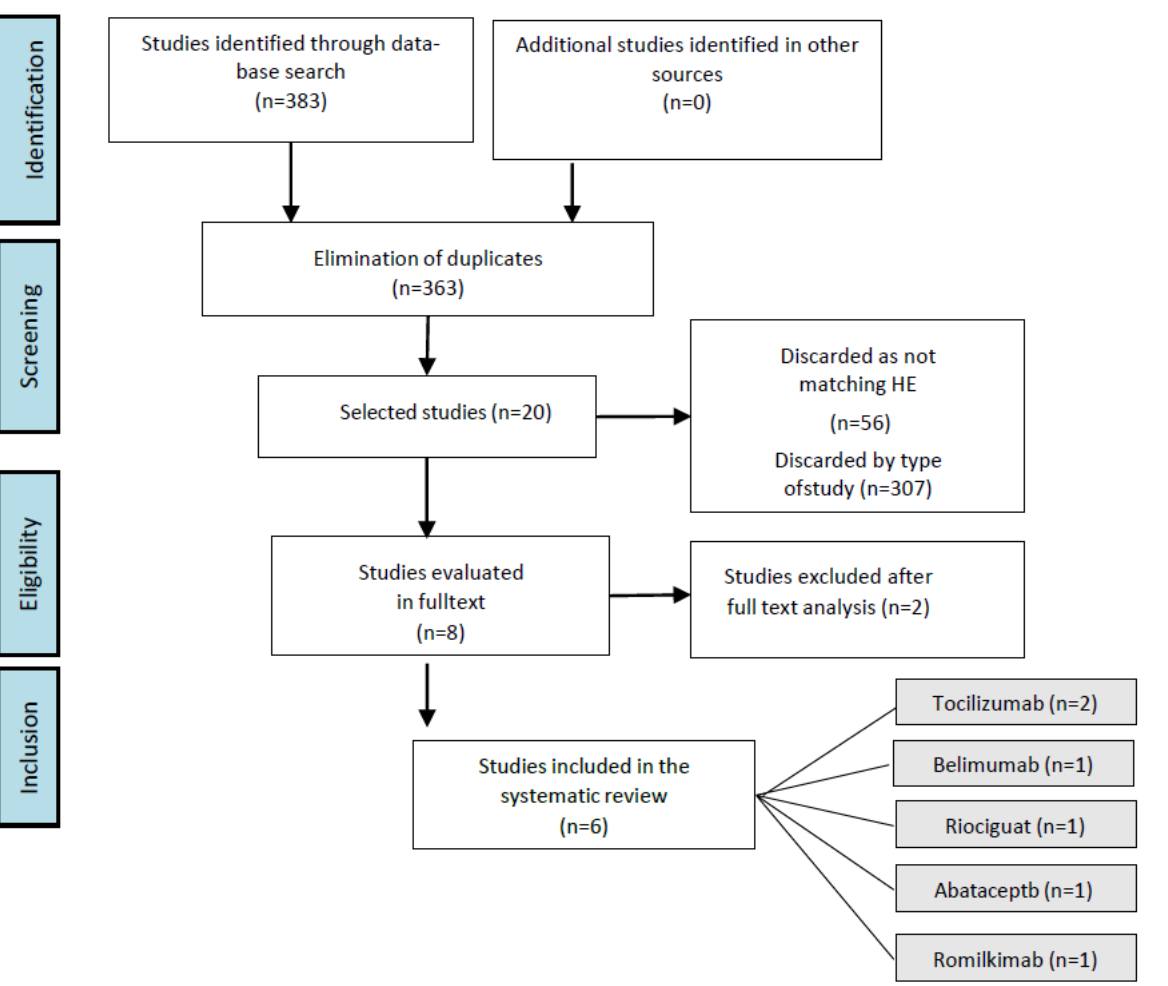
Figure 1. Flow chart depicting the processes of identifying and selecting relevant studies according to the Preferred Reporting Items for Systematic Reviews and Meta-Analyses (PRISMA) guidelines.